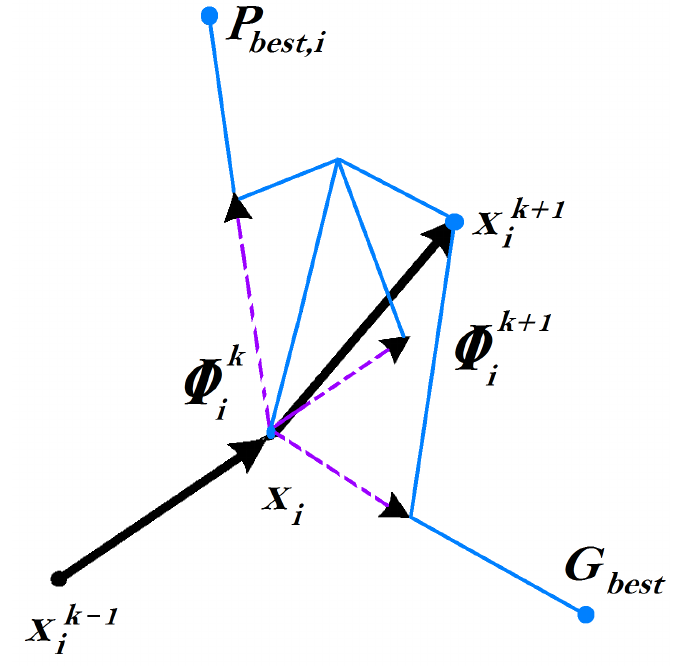
Figure 4. Movement of particles involved in the optimization process of PSO